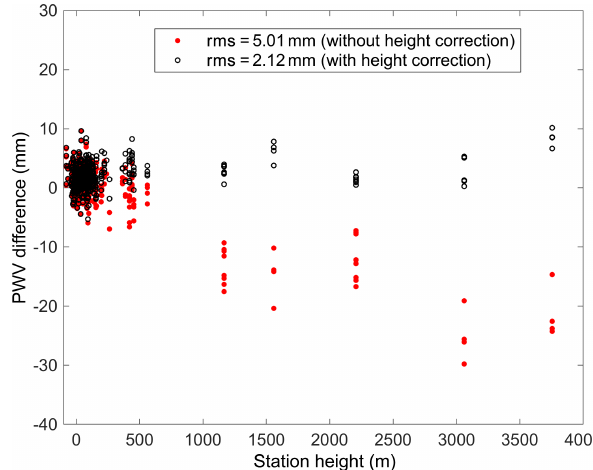
Figure 1. PWV biases between GNSS and ECMWF at all the GNSS stations without (red dots) and with (black cycles) height